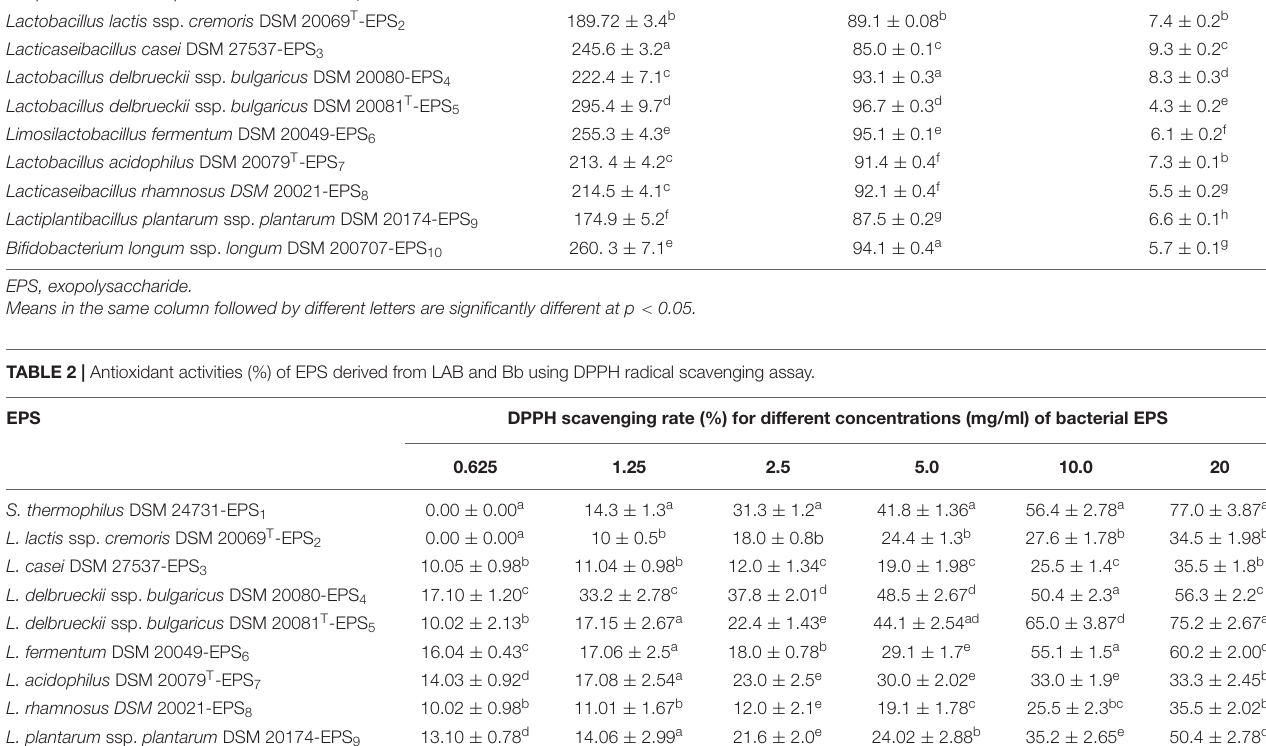
( Table 2 ). The ability of a non-enzymatic antioxidant defense mechanism is represented by TAC. Table 3 shows that the antioxidant capacity ranged between 0.75 and 2.5%; the highest